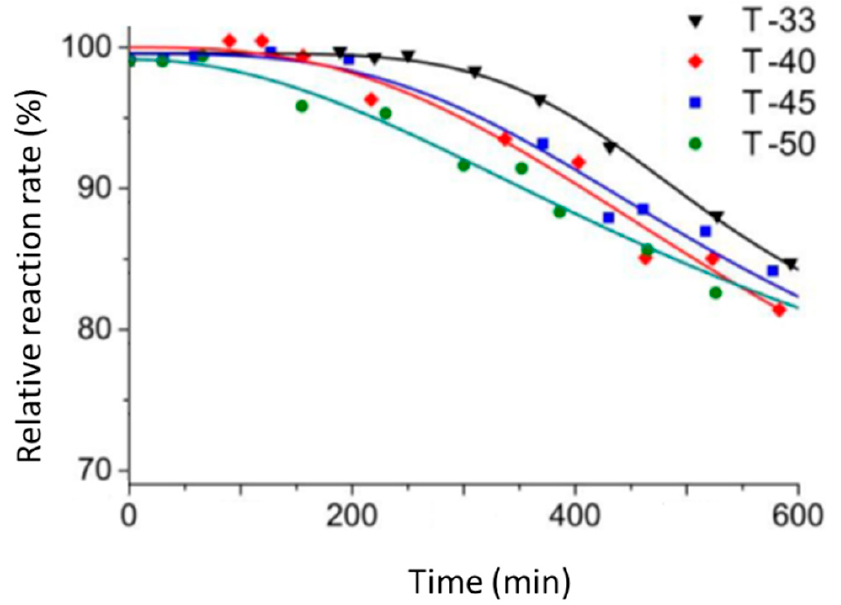
Figure 4. Reaction rate over composite magnetic catalysts in the RF-flow reactor as a function of time on stream. Reaction conditions: concentration of 4-phenylbutyric acid: 50 mmol L − 1 , concentration of aniline: 50 mmol L − 1 . Flow rate: 110 µL min − 1 . Temperature: 150 °C, pressure: 7 bar.